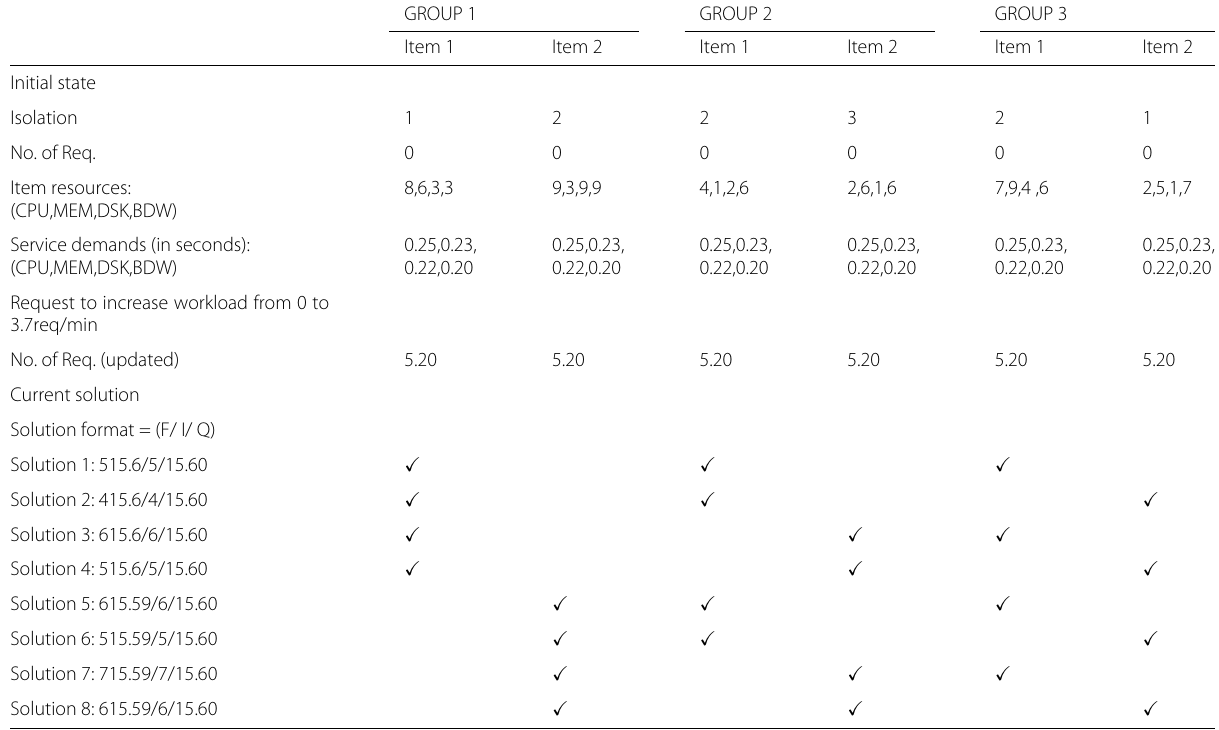
Table 2 An example of optimal component deployment GROUP 1 GROUP 2 GROUP 3 Item 1 Item 2 Item 1 Item 2 Item 1 Item